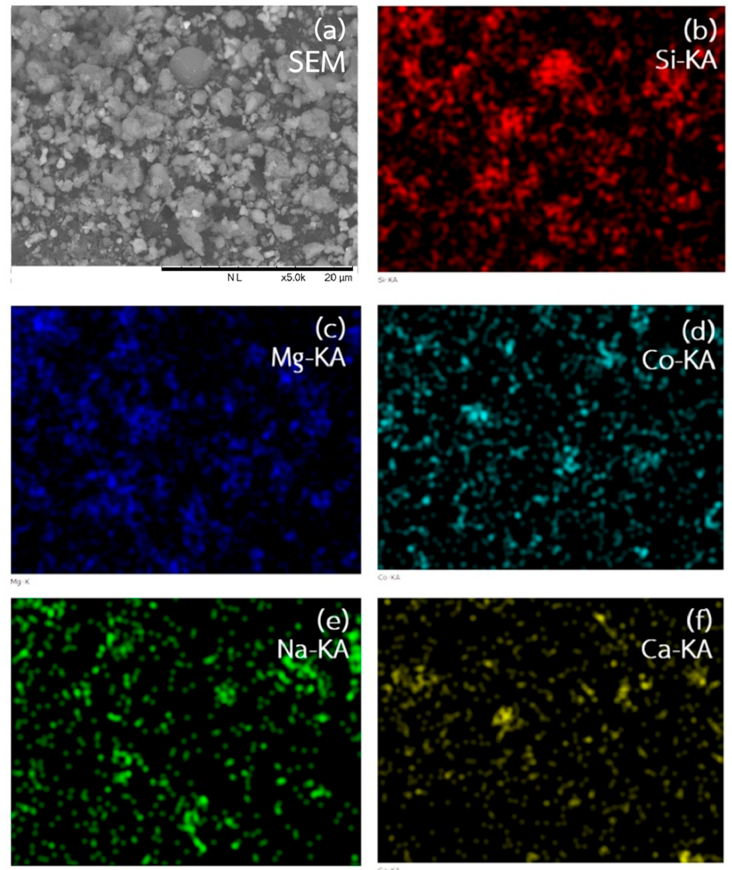
Figure 6. Scanning electron microscope (SEM) micrograph and energy dispersive spectroscopy (EDS) data of Co 0.4 Mg 1.6 SiO 4 powder: ( a ) morphology; ( b ) silicon; ( c ) magnesium; ( d ) cobalt; ( e ) sodium; and ( f ) calcium.